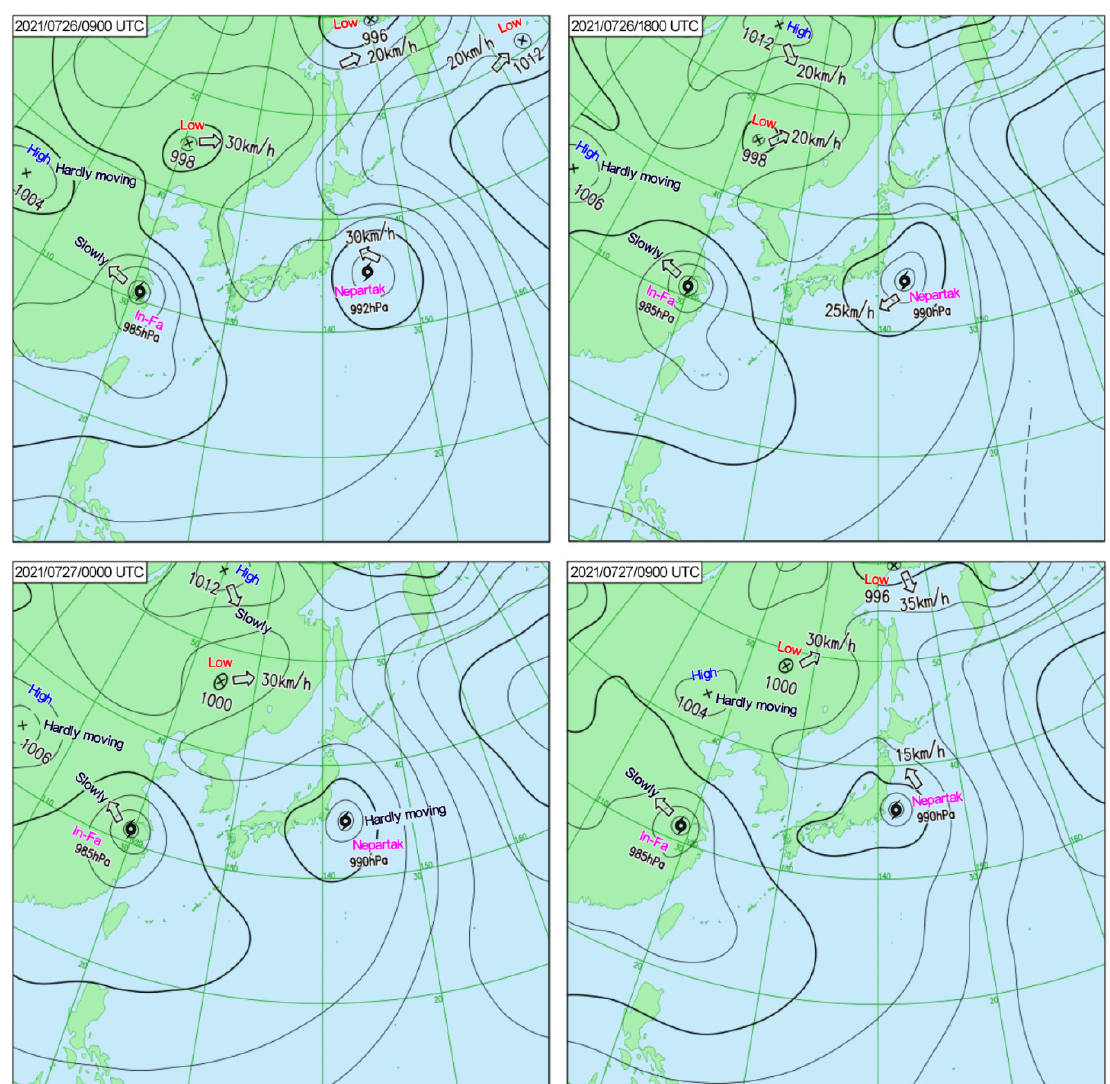
Figure 4. Surface analysis weather maps during Typhoon In-Fa landfall provided by the Japan Meteorological Agency (JMA).